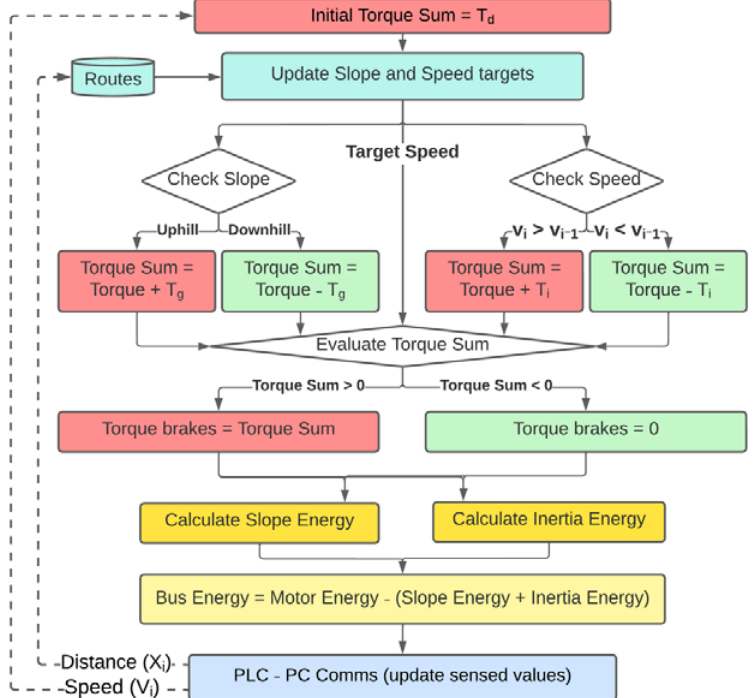
Figure 7. General Operation Algorithm.